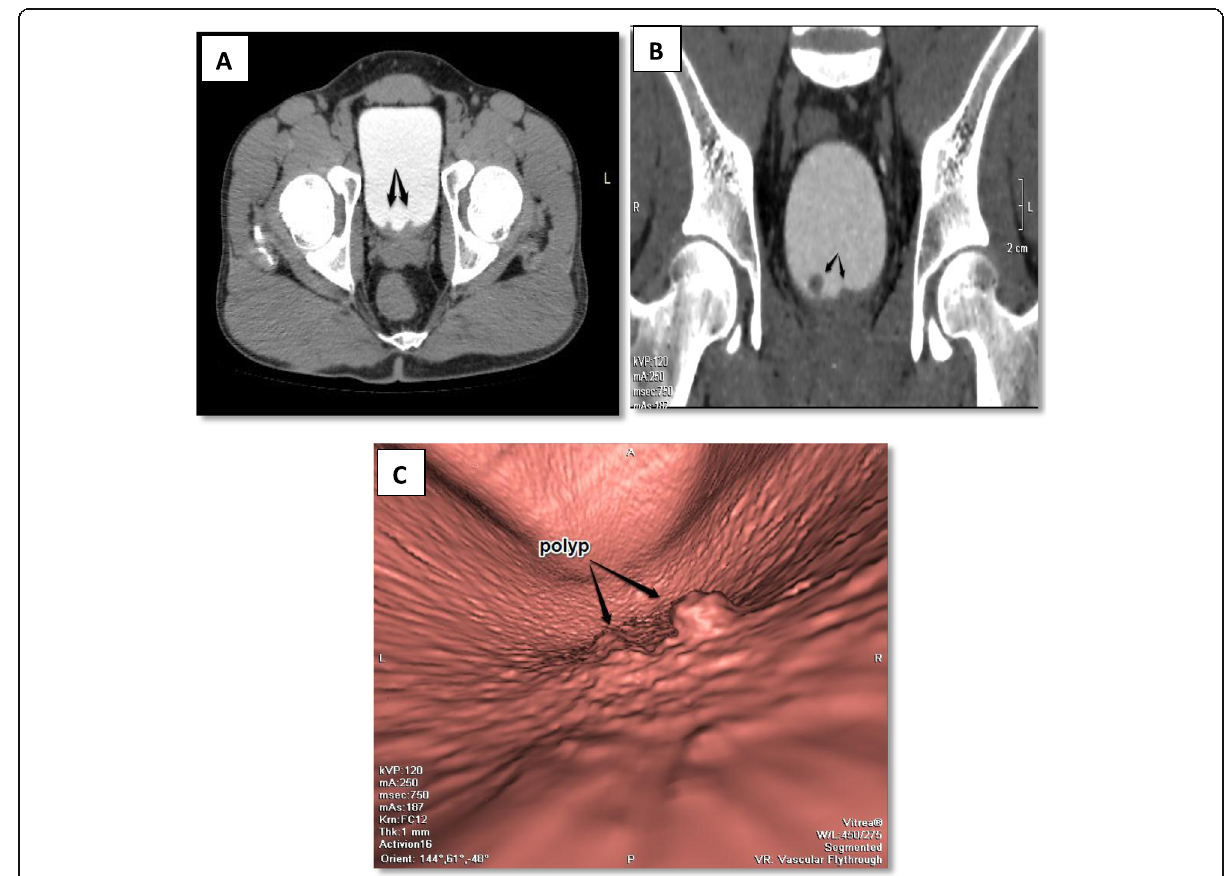
Fig. 1 a , b 47-year-old male patient presented by hematuria. 2D images showed urinary bladder basal small polypoidal masses about (1.3 × 1 cm) and (0.5 × 0.4 cm) with clear perivesical fat (arrowed), no gross lymphadenopathy nor distant metastases could be detected. c Virtual image shows the two small polypoid masses (arrowed). Conventional cystoscopy revealed the two basal polypoidal masses with nearly the same sizes and morphology as those obtained by the virtual images, biopsy was taken and revealed noninvasive papillary transitional cell carcinoma